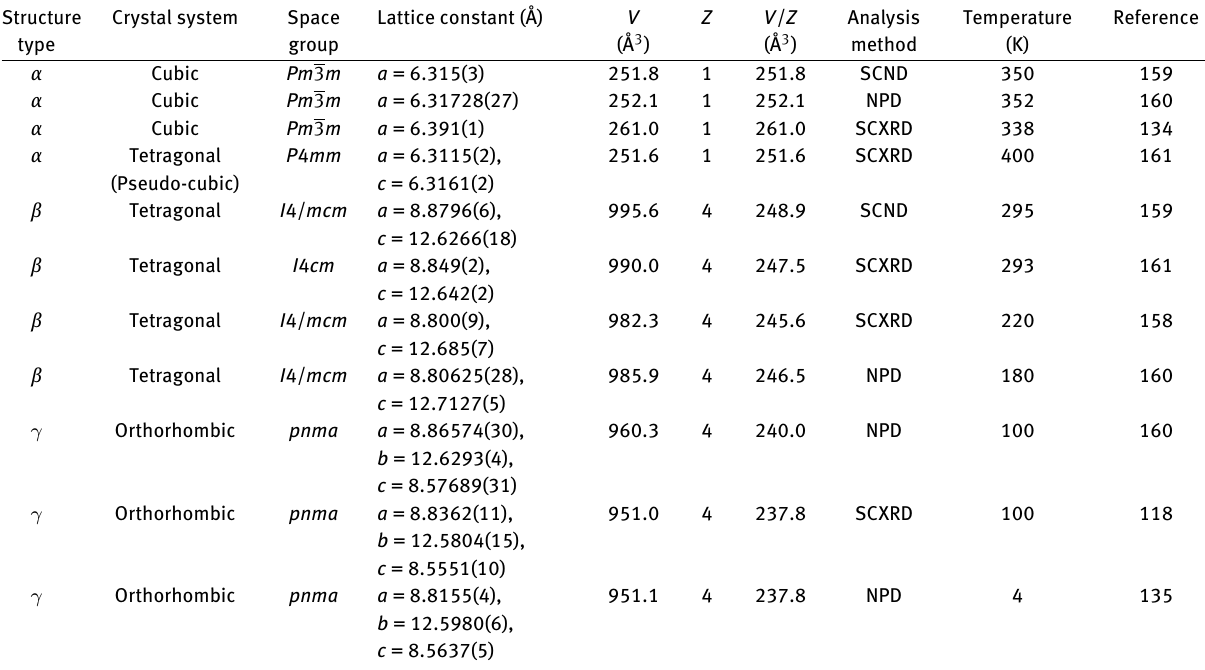
Table 3: Reported crystal systems and lattice constants of CH 3 NH 3 PbI 3 . SCND: single crystal neutron diffraction, NPD: neutron powder diffraction, SCXRD: single crystal X-ray